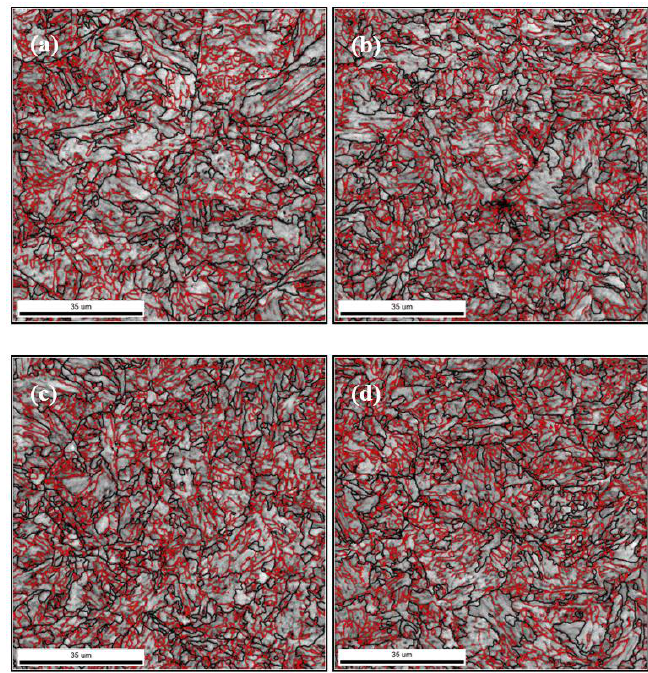
Figure 9. The EBSD (electron back-scattered diffraction) misorientation angle figures of the specimens with different finish rolling temperatures: ( a ) 850 ◦ C; ( b ) 830 ◦ C; ( c ) 810 ◦ C and ( d ) 790 ◦ C. The red line and the black line represent the misorientation angle in the range 2 ◦ –15 ◦ and greater than 15 ◦ ,